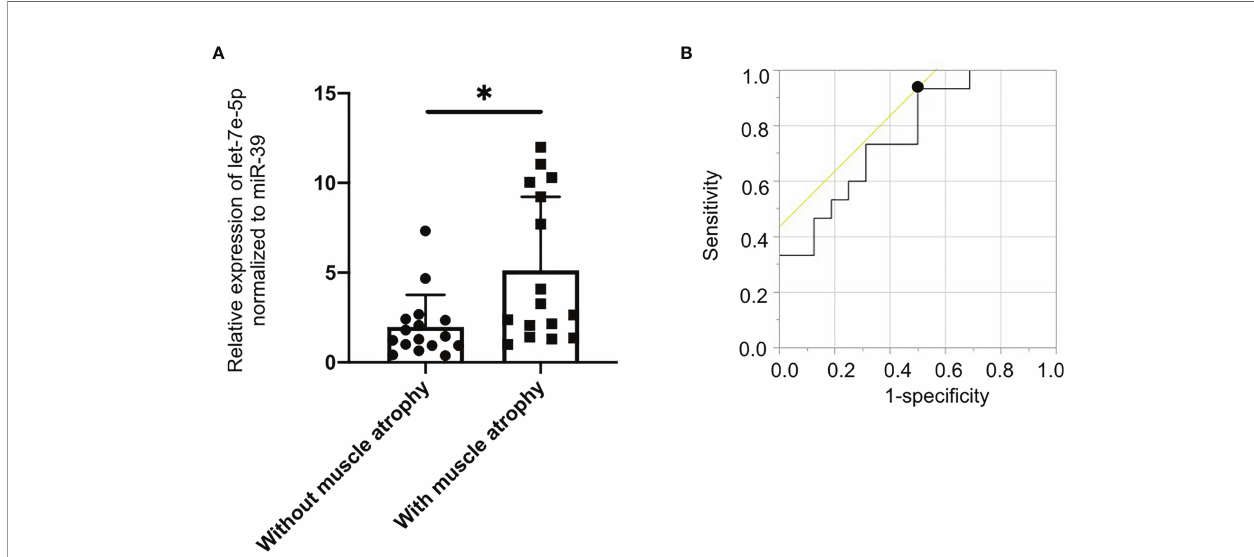
FIGURE 4 | Decreased levels of serum circulating let-7e-5p in patients with muscle atrophy compared to patients without muscle atrophy. (A) Relative expression of serum circulating let-7e-5p normalized to miR-39 in the patients with and without muscle atrophy is shown. Serum let-7e-5p expression in patients without muscle atrophy (7.1 ± 10.1) was signi fi cantly higher than that in patients with muscle atrophy (2.0 ± 1.8) (p = 0.028). Data represent the means±SD. (B) Optimal cut-off point for serum circulating let-7e-5p level, for the presence of sarcopenia, is 1.302 (AUC 0.767, 95% CI, 0.600 – 0.934, sensitivity = 0.933, speci fi city = 0.500, p = 0.001). *p = 0.05 by Pearson ’ s chi-square test.